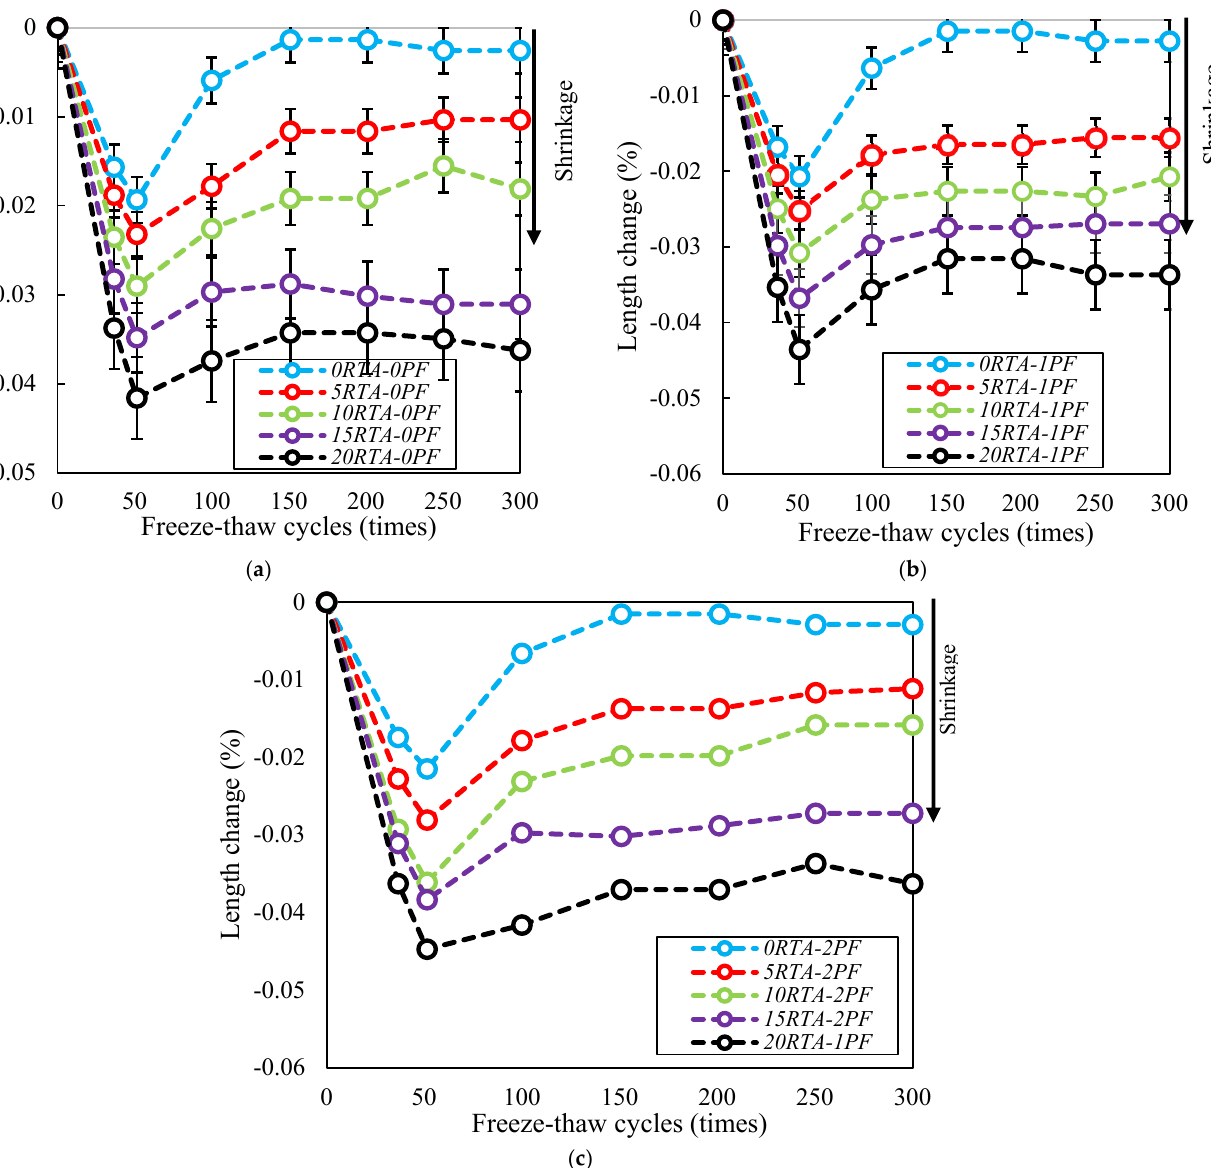
Figure 23. Change the length of the concrete mixtures having different PF and RTA fractions. ( a ) without PF, ( b ) with 1% PF and ( c ) 2% PF